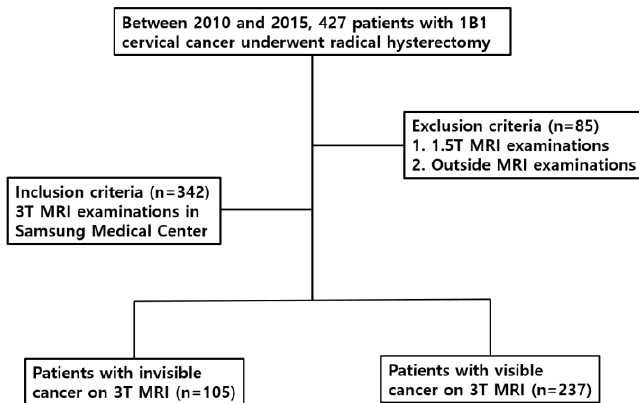
Figure 1. Flow diagram of selecting the study population.